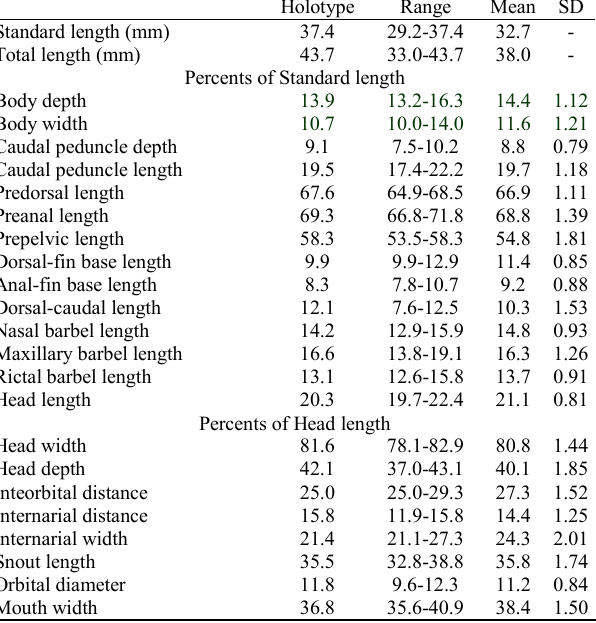
Table 1. Morphometric data of holotype and paratypes of Trichomycterus payaya (n = 15). The ranges include the holotype. SD = Standard